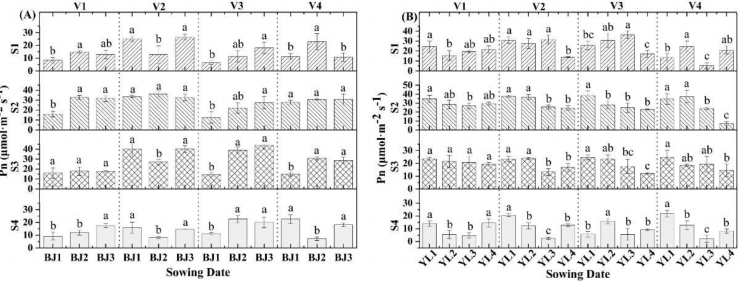
Figure 2. The leaf net photosynthesis (Pn) of broomcorn millet under different treatments in Baoji ( A ) and Yulin ( B ). V and S represent the variety and measuring stage, BJ and YL represent the sowing date in Baoji and Yulin, respectively. This applies to the other figures. The different lowercases in ( A , B ) represent the significant differences among treatments in each group at the two